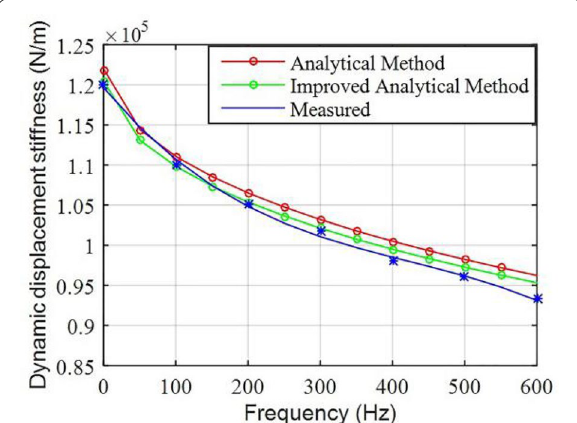
Figure 11 Measured dynamic current stiffness at different frequency compared with analytical results